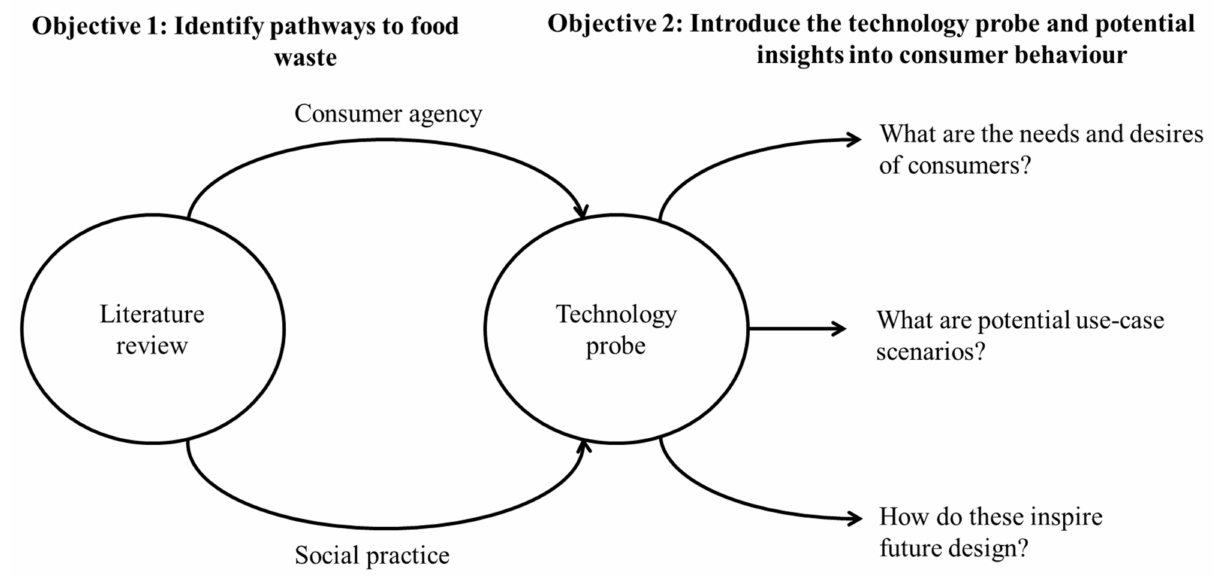
Figure 1. Summary of